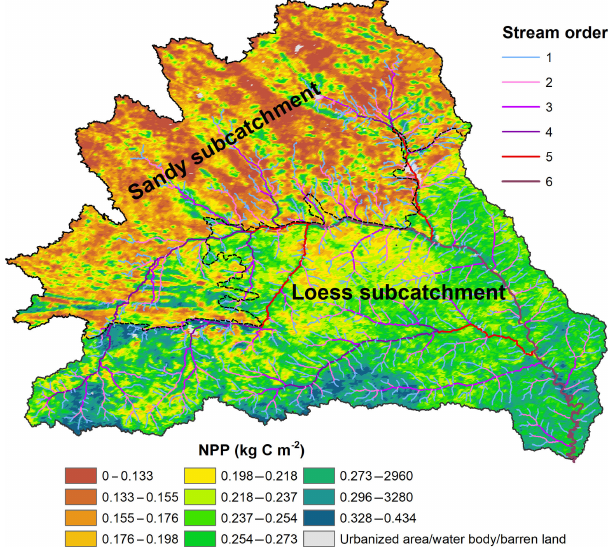
Figure 7. Spatial distribution of NPP within the Wuding River catchment in 2015 showing significant differences between the northwestern sandy and southeastern loess